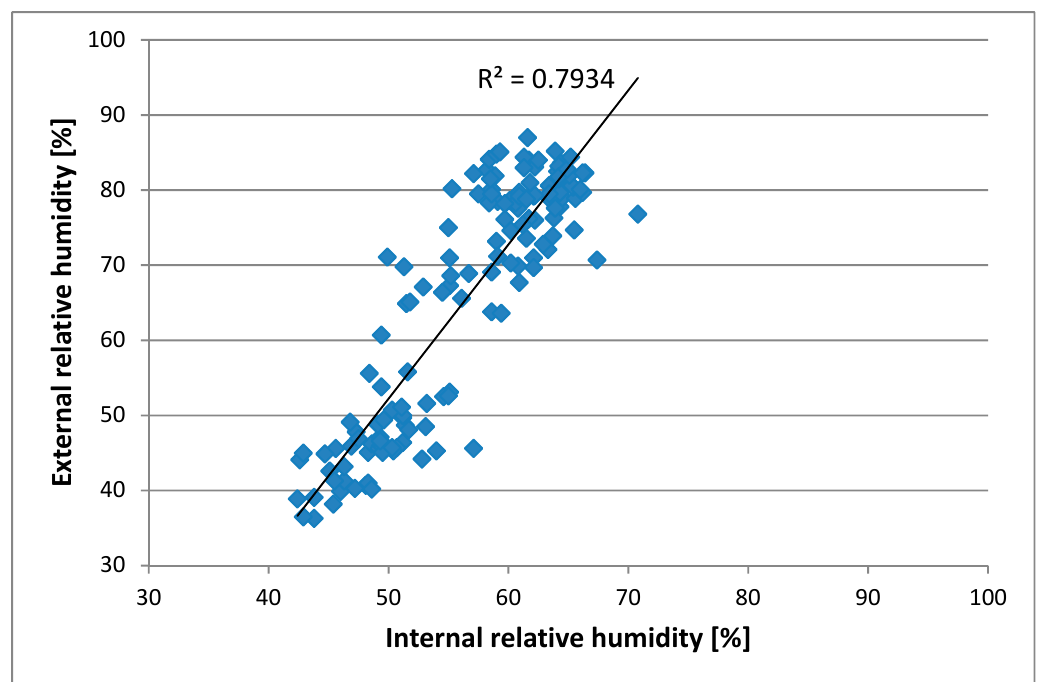
Figure 9. Correlation between external and internal relative humidity of the hives.